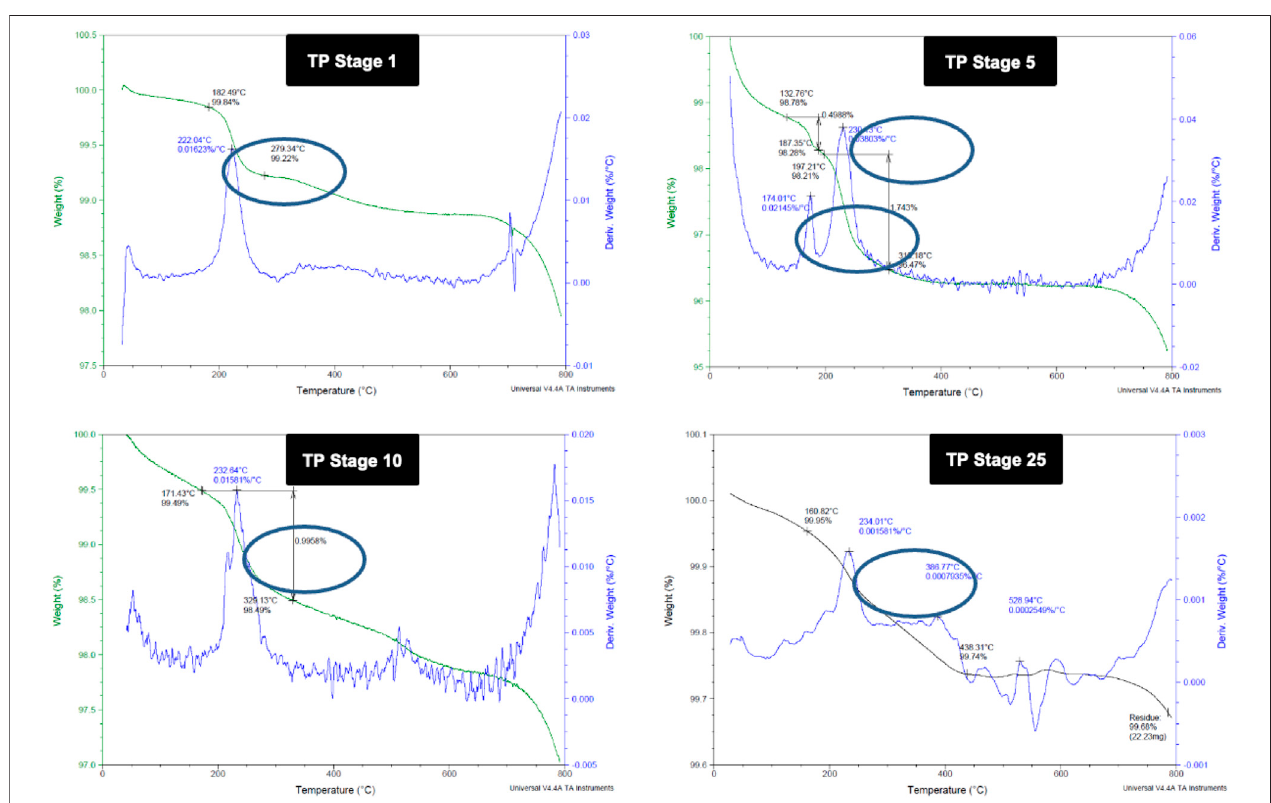
FIGURE 2 | Thermogravimetric analysis (TGA) of different stages of Thamira parpam prepared by the traditional ancient method (A) Stage-1 TP; (B) Stage-5 (C) Stage-10 TP (D) Stage-25 TP.